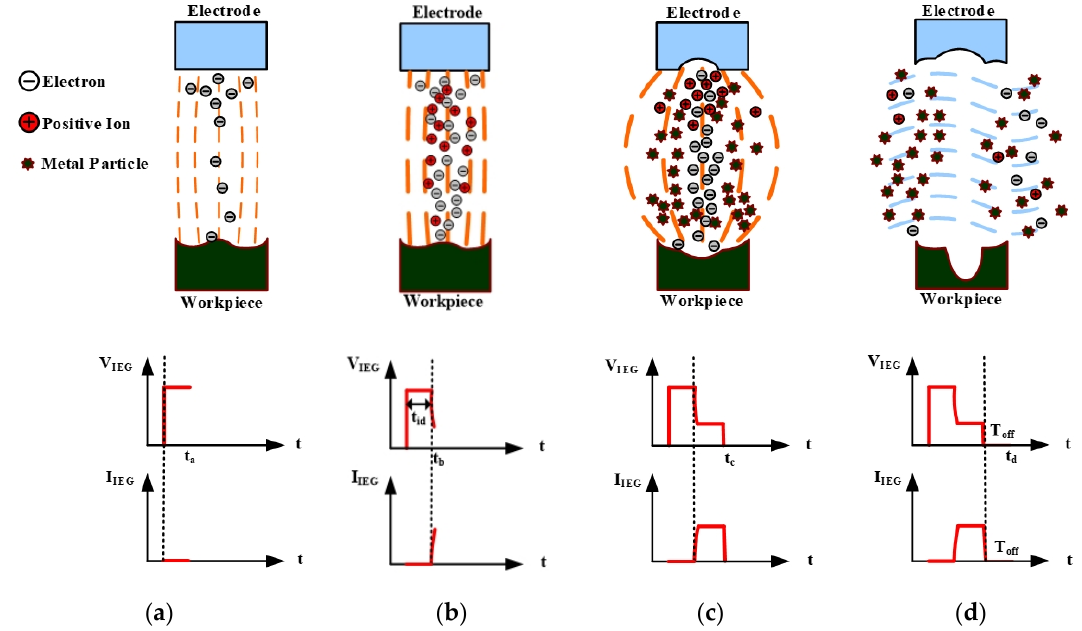
Figure 1. Process of electrical discharge machining (EDM): ( a ) the discharge, ( b ) ionization, ( c ) slag generation and expulsion, and ( d ) insulation recovery of dielectric fluid.